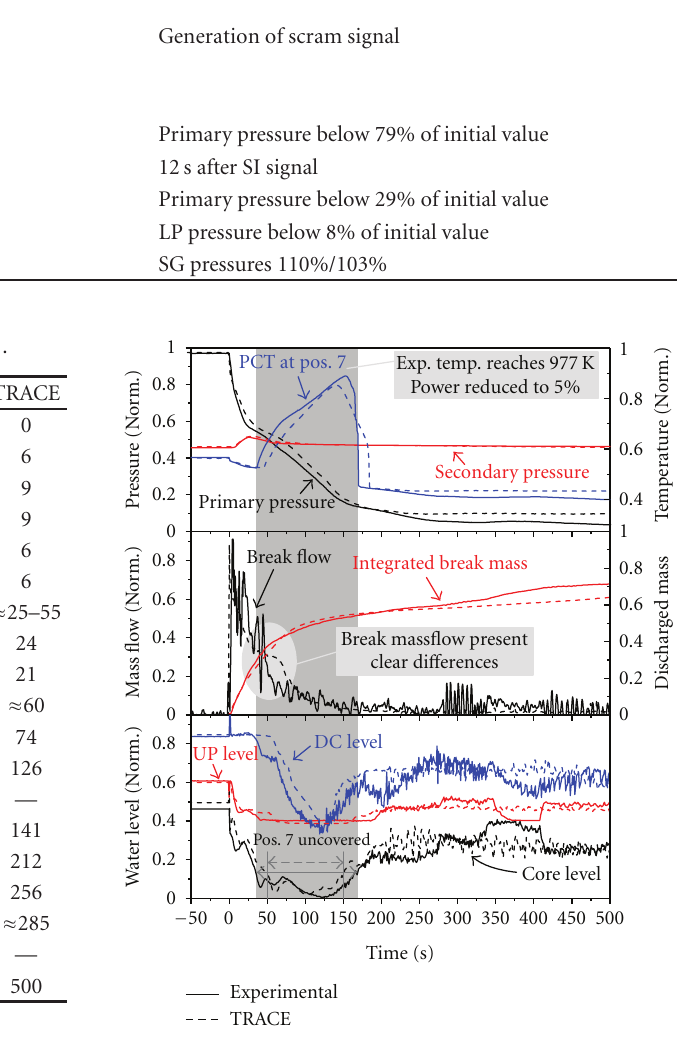
Figure 5: TRACE results for Test 2. From top to bottom: (1) pri- mary and secondary pressure along with the cladding temperature at pos. 7 rod (4,4), (2) break flow and integrated discharged mass, and (3) RPV water